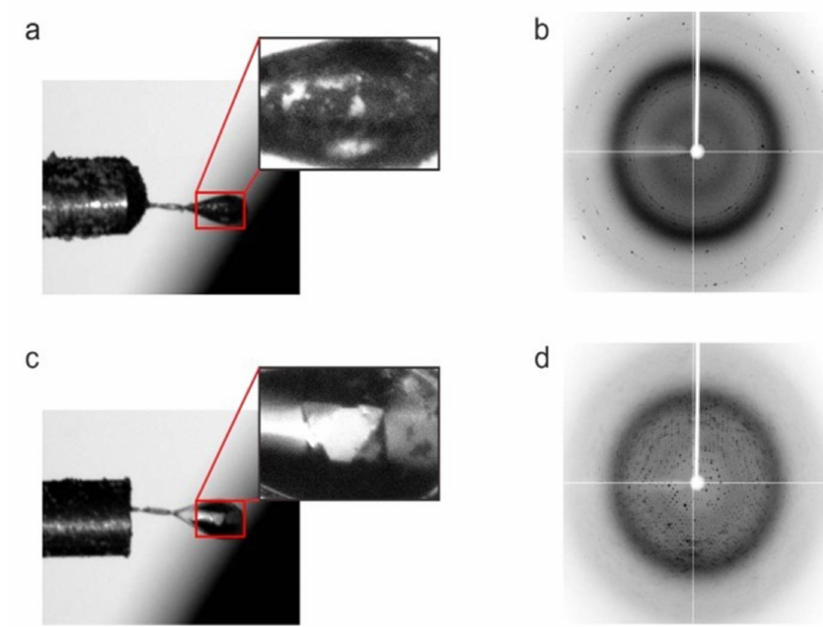
Figure 3. The importance of cryoprotection in diffraction quality. Incorrect cryoprotection of GAPDH protein forms an ice ring and lowering the quality of X-ray data ( a , b ). However, correct selection of cryoprotection for GAPDH crystal leads to much better quality of X-ray data ( c , d